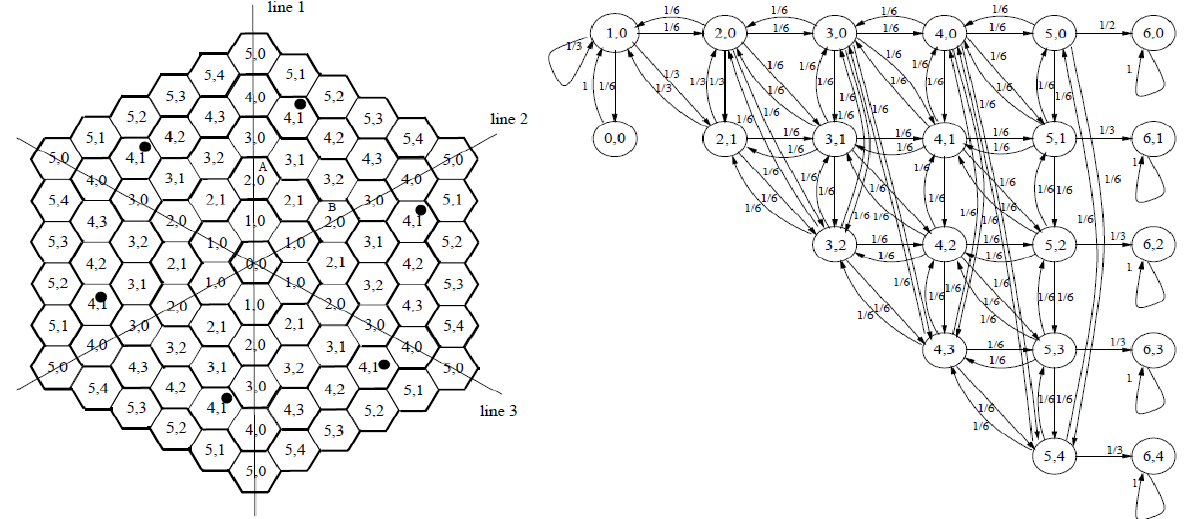
Figure 7. Type Classification and State diagram of a six-sublayer PAN area